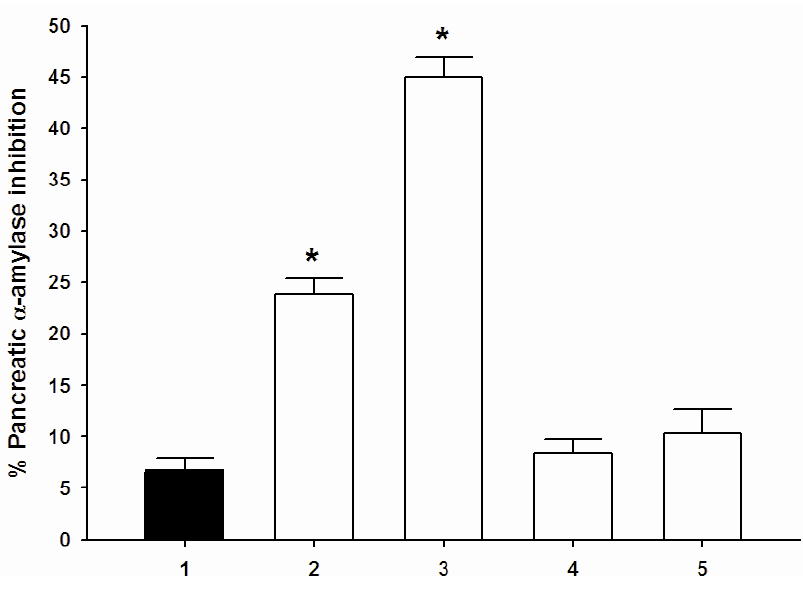
Figure 4. The combined effect of acabose and cyanidins on pancreatic  -amylase inhibition. ( 1 ): 3.12  M acarbose; ( 2 ): 3.12  M acarbose + 1  M cyanidin; ( 3 ): 3.12  M acarbose + 1  M cyanidin-3-glucoside; ( 4 ): 3.12  M acarbose + 1  M cyanidin-3-galactoside; ( 5 ): 3.12  M acarbose + 1  M cyanidin-3,5-diglucoside. Result are expressed as means  S.E.M; n = 3. * P < 0.001 compared with acarbose (3.12  M)